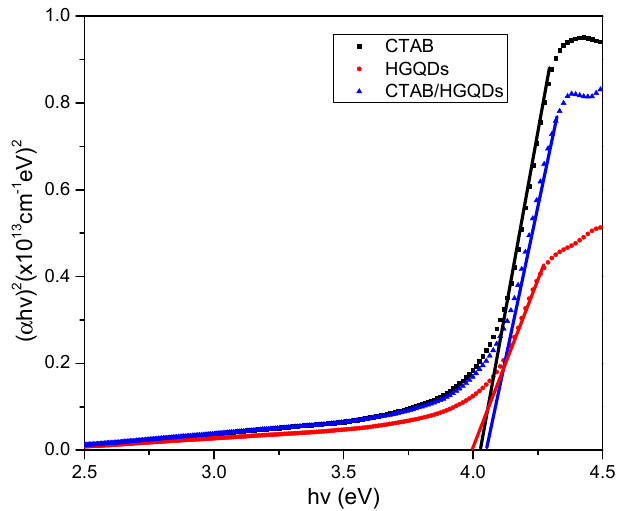
Figure 9. Determination of the optical band gap from ( α hv ) 2 versus hv of all thin films.